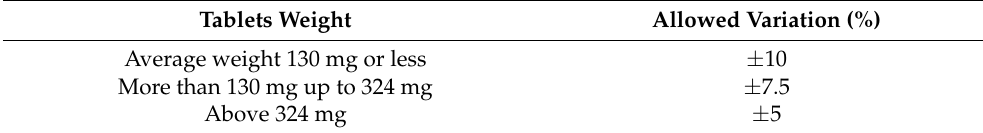
Table 1. Allowed % age deviation limits in tablet weight